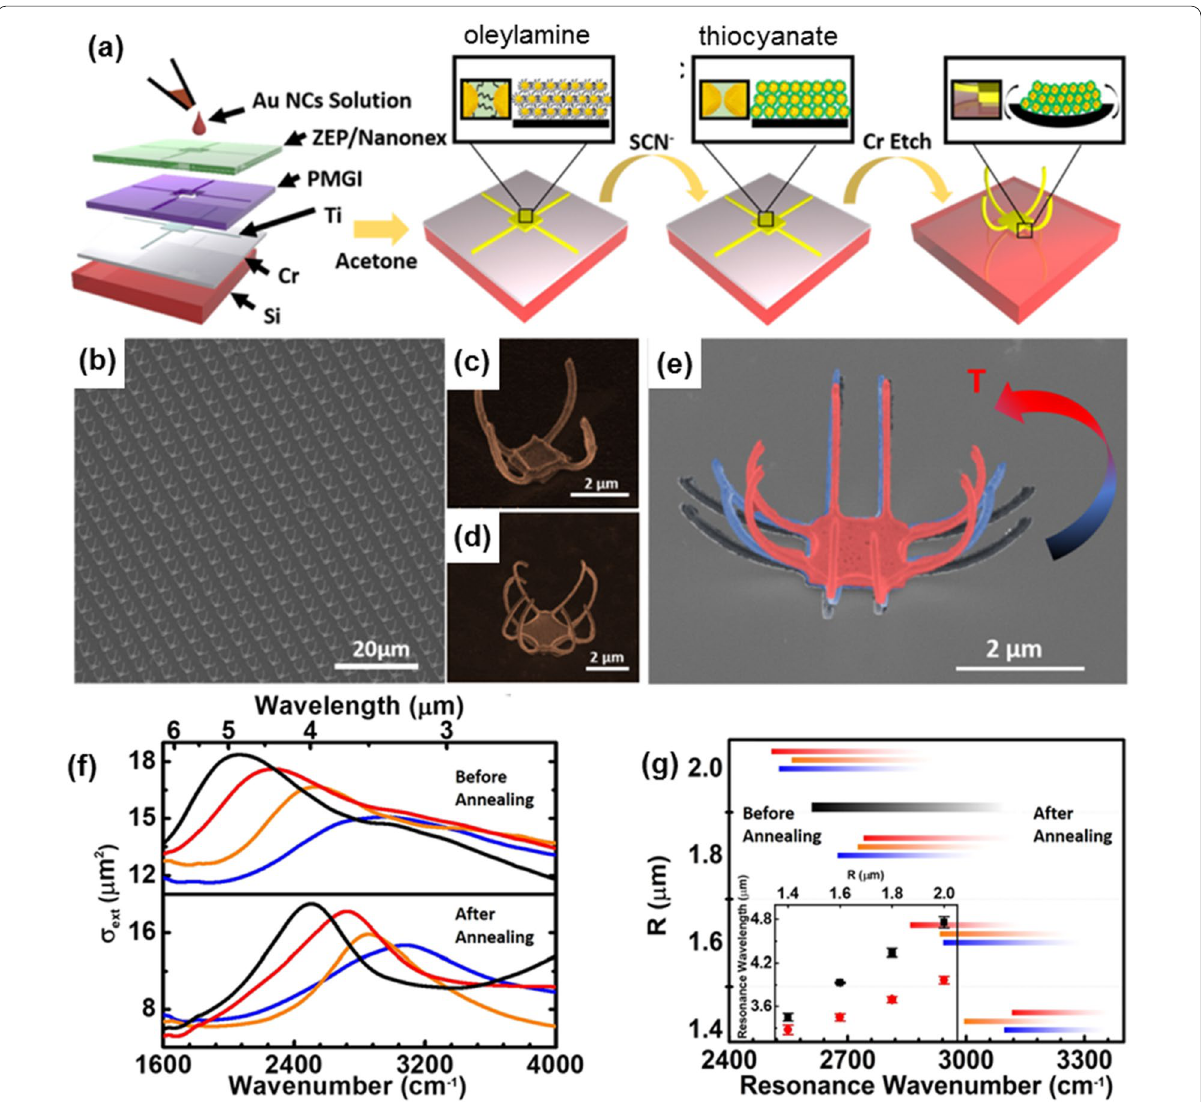
Fig. 20 a Schematic of the fabrication of NP/metal bilayer metamaterials. b – d Representative SEM images of 3D metamaterials after. e Overlaid SEM images of meta-atoms; before annealing (black), annealing at 160 °C for 5 min (blue) and 60 min (red). f Extinction cross-sections for NP/metal metamaterials with varying R. Reproduced with permission from [120]. g Relation between resonance peak and the radius. The inset shows the shift of the resonance peak position. The black data points indicate samples before annealing and red, orange, and blue data points represent samples after annealing at 150, 120, and 90 °C for 24 h, respectively. Reproduced with permission from